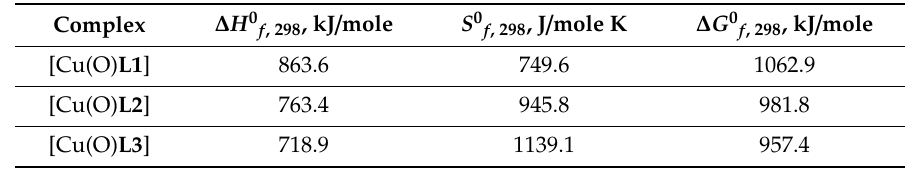
Table 2. Standard thermodynamic parameters of formation ( ∆ H 0 f , 298 , S 0 f , 298 and ∆ G 0 f , 298 ) for